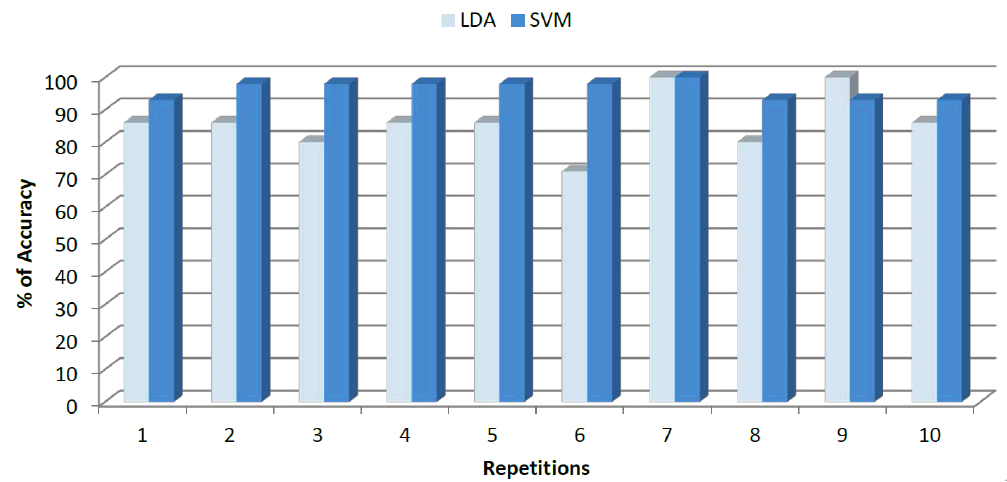
Figure 8. Final results obtained for geographical origin classification after k -fold cross-validation data using LDA and SVM models.